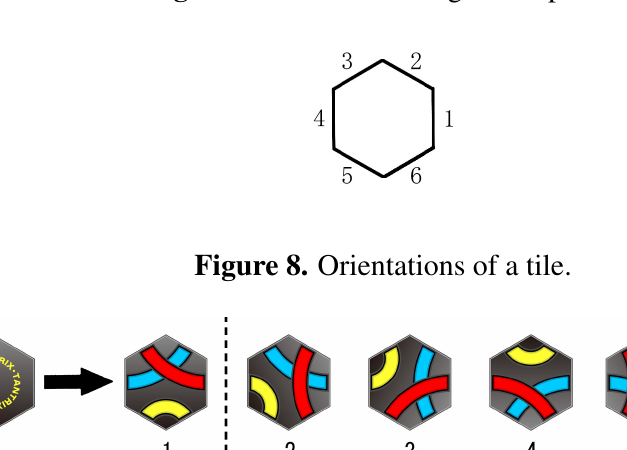
Figure 7. Numbers of edges of a place.